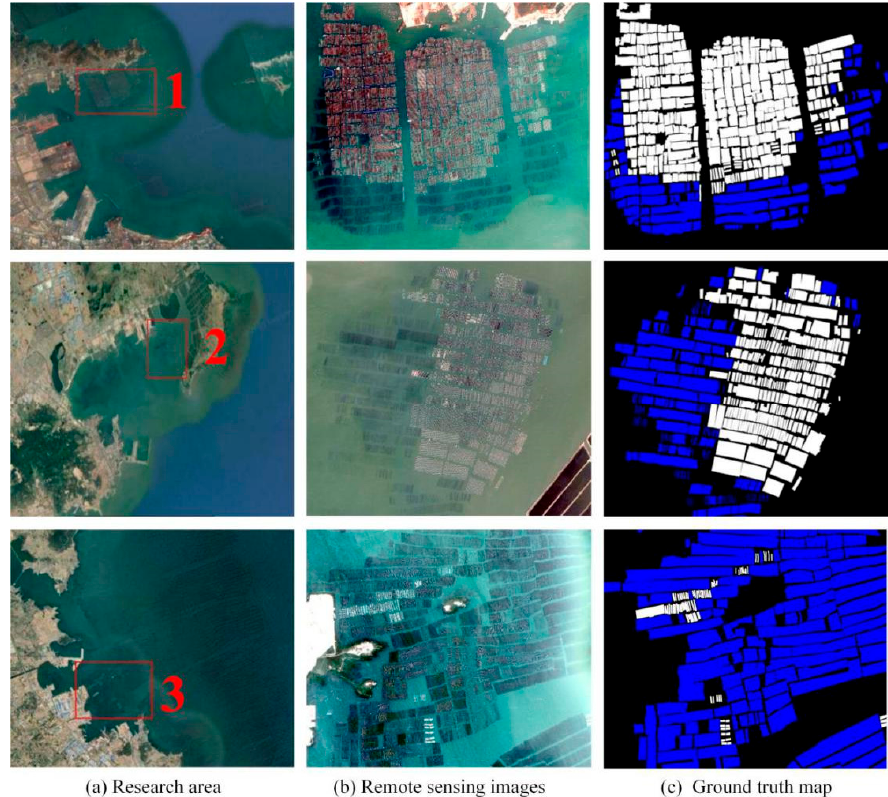
Figure 10. ( a ) The selected part in the red box is the study area; ( b ) remote sensing images corresponding to the study area; ( c ) ground truth map, in which black is the background, white is fish row cage aquaculture, and blue is floating raft aquaculture.